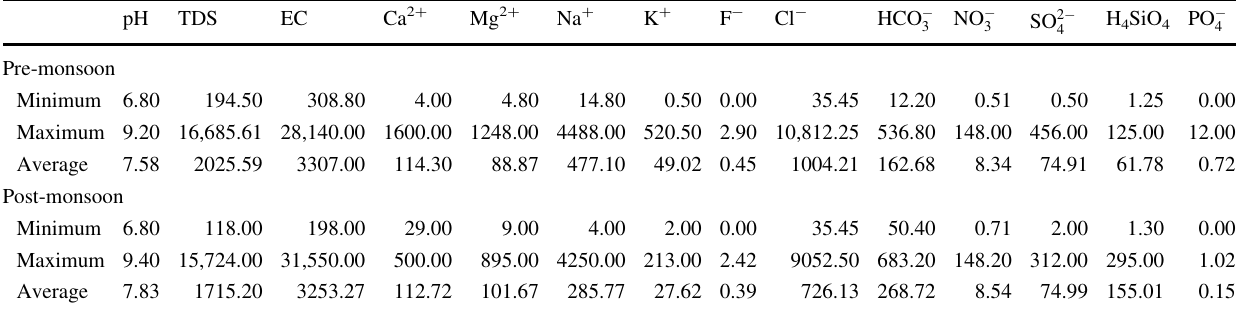
Table 2 Range of chemical ions during PRM and POM (all values are in mg l - 1 except for those of pH and EC which are in l S cm - 1